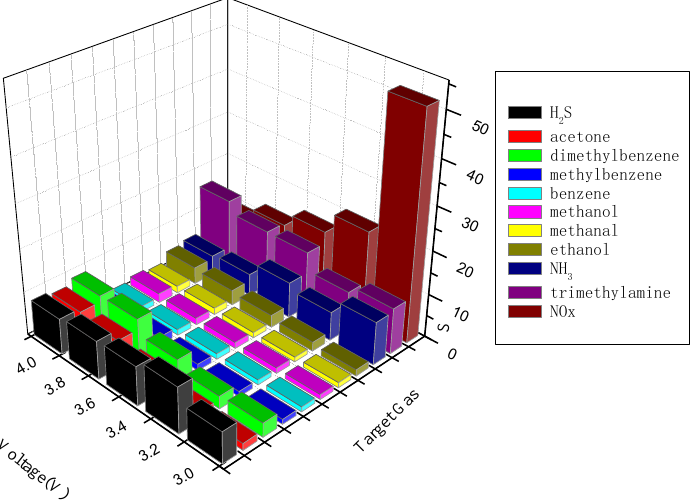
sensors to various gases at different operating 3